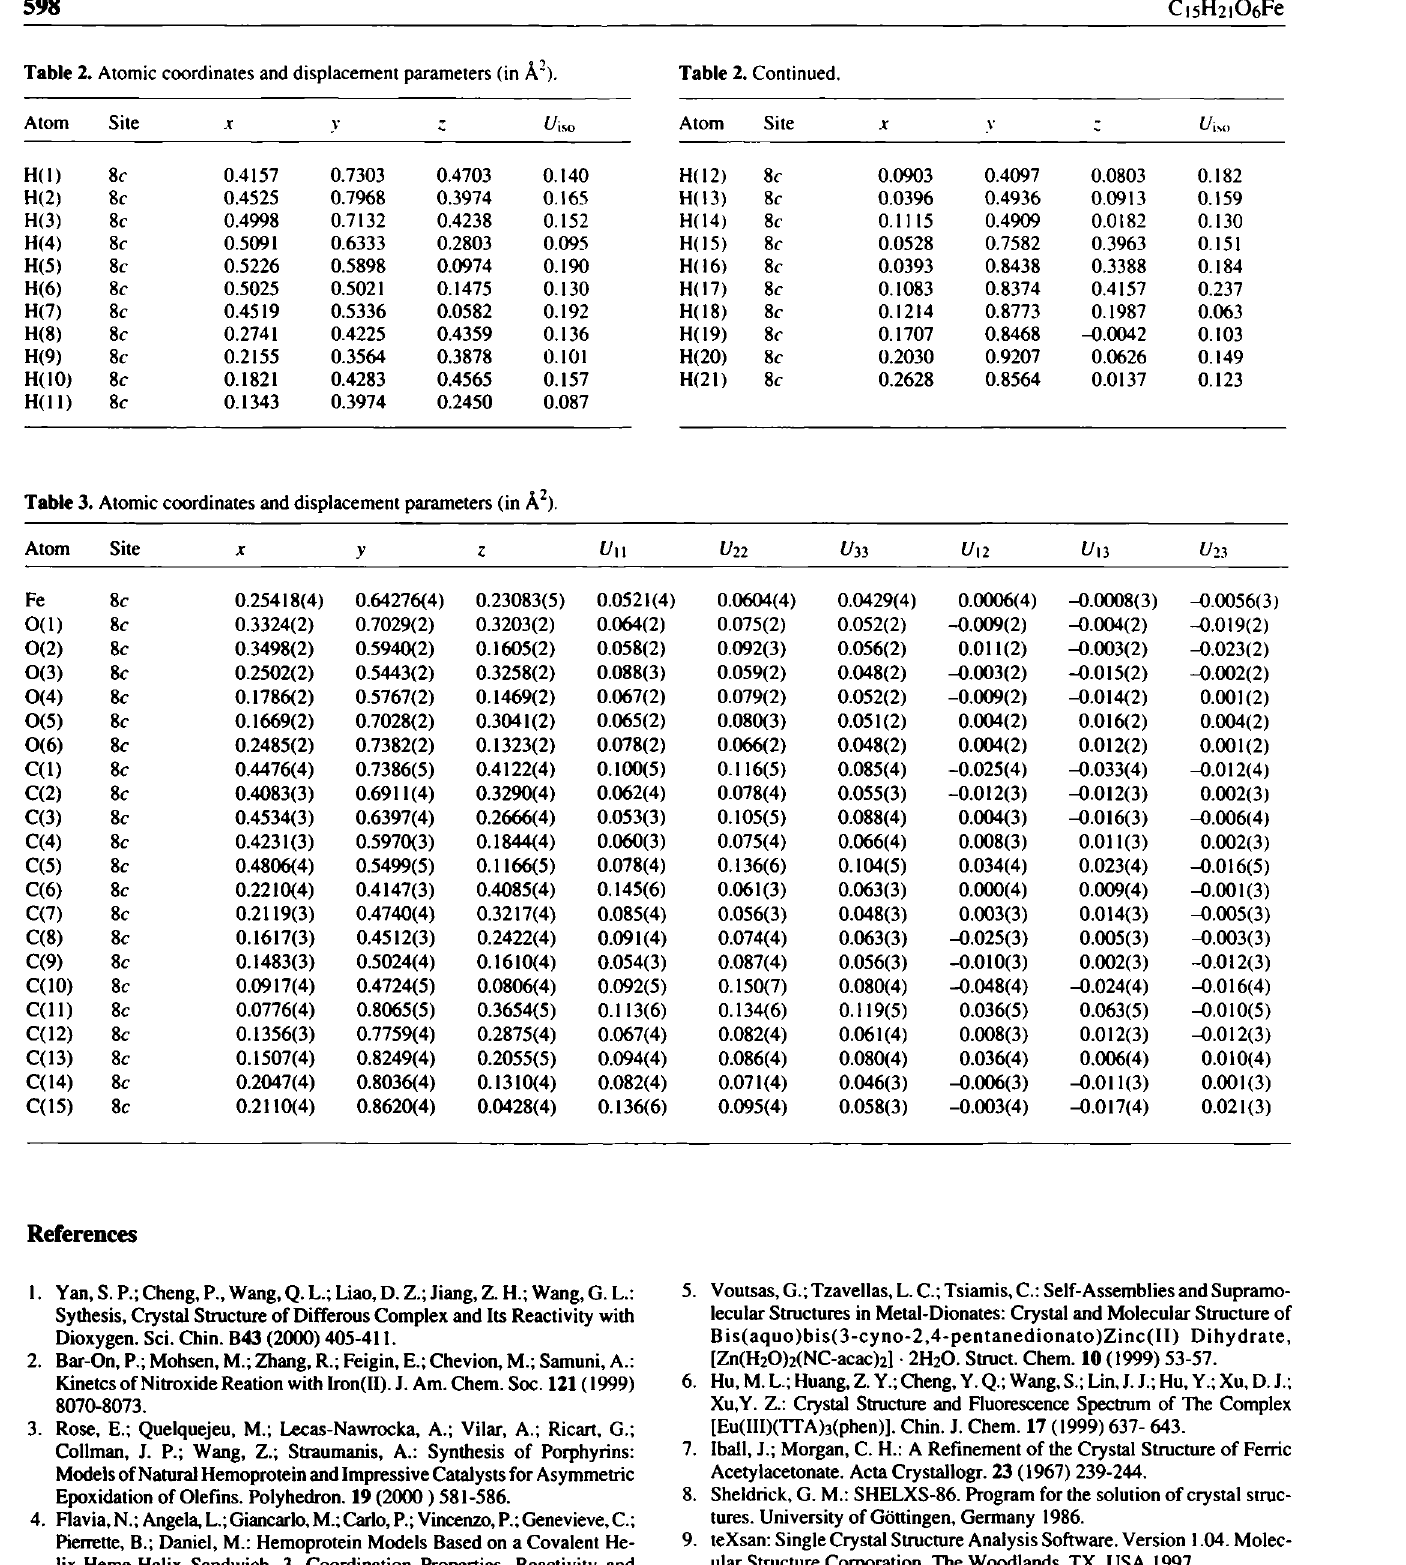
Table 2. Atomic coordinates and displacement parameters (in Ä 2 ).